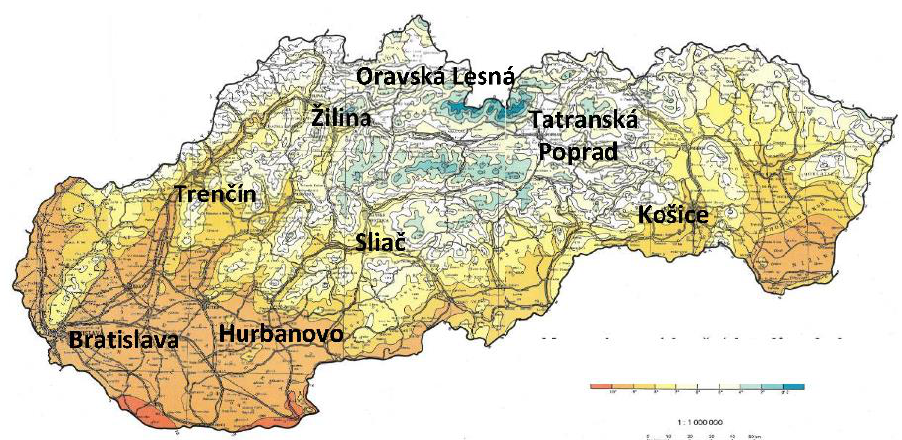
Figure 10. Map of average annual exhalation temperatures according to STN 73 6114:1997 [40] with the designation of climatological stations according to Table 2. Reprinted with permission from [40].